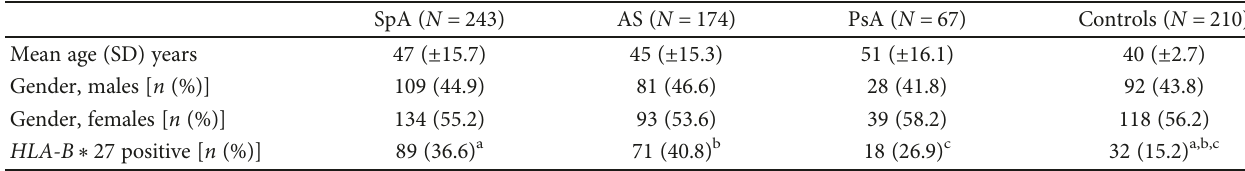
Table 2: Baseline characteristics of patients and healthy volunteers